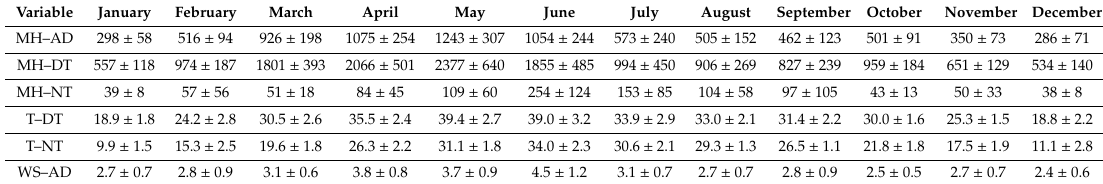
Table 3. Summary of all day (AD), daytime (DT), and nighttime (NT) averages ( ± standard deviations) of mixing heights (MH in m), near surface temperature (T in ◦ C), and near surface wind speeds (WS in m / s) by month. Data is extracted from Weather Research Forecasting (WRF) model simulations using the National Centers for Environmental Prediction (NCEP) reanalysis fields for the year